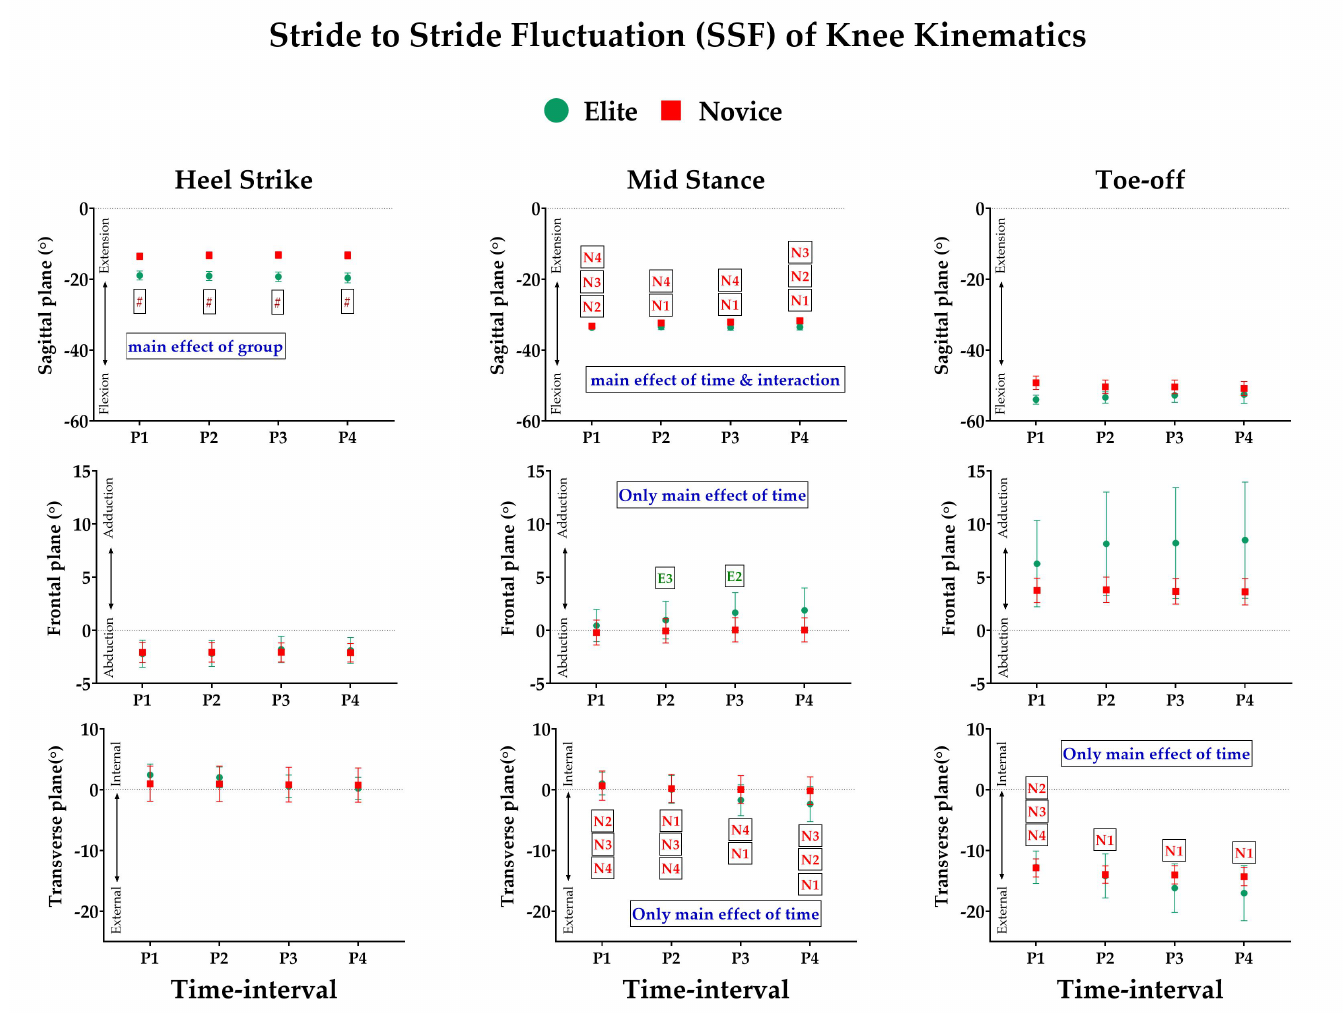
Figure A3. The results of the kinematics of knee joint SSF angle between elites (circle) and novices (square) in each phase of the prolonged run. The computed variable of SSF is represented on the Y -axis. The time-interval calculated by increasing the window size every five minutes is represented on the X -axis (P1: 0 to 5 min; P2: 0 to 10 min; P3: 0 to 15 min; and P4: 0 to 20 min). The figure depicts a significant main effect of group, time interval, and interaction. The outcome of a pairwise comparison for the time-interval difference is represented by letters (N for novice and E for the elite) with the corresponding time-interval with a significant difference (e.g., N1 for the novices at time interval 0–5 min). Significant differences in a group for a specific time interval are marked with a “#”. (Note: only results with significant interaction have been